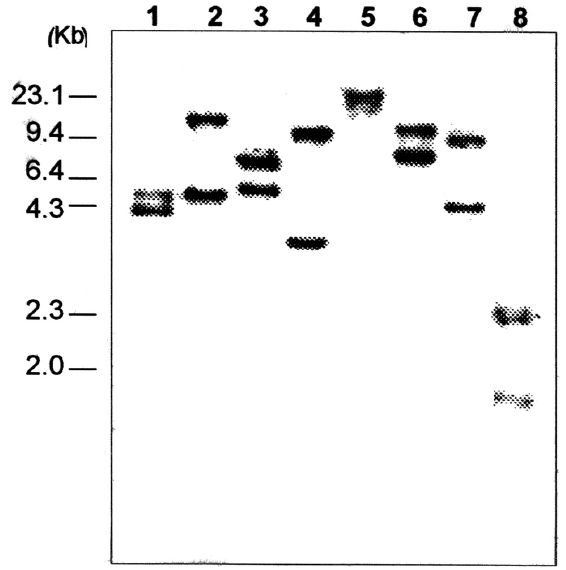
Figure 1 - Southern blot analysis of total DNA from Penicillium griseoroseum . Total DNA was digested with Bam HI (1), Cla I (2), Eco RI (3), Eco RV (4), Hin dIII (5), Sac I (6), Sal I (7), and Xba I (8), analyzed on 0.8% agarose gel, and transferred to nylon membrane. A 420-bp